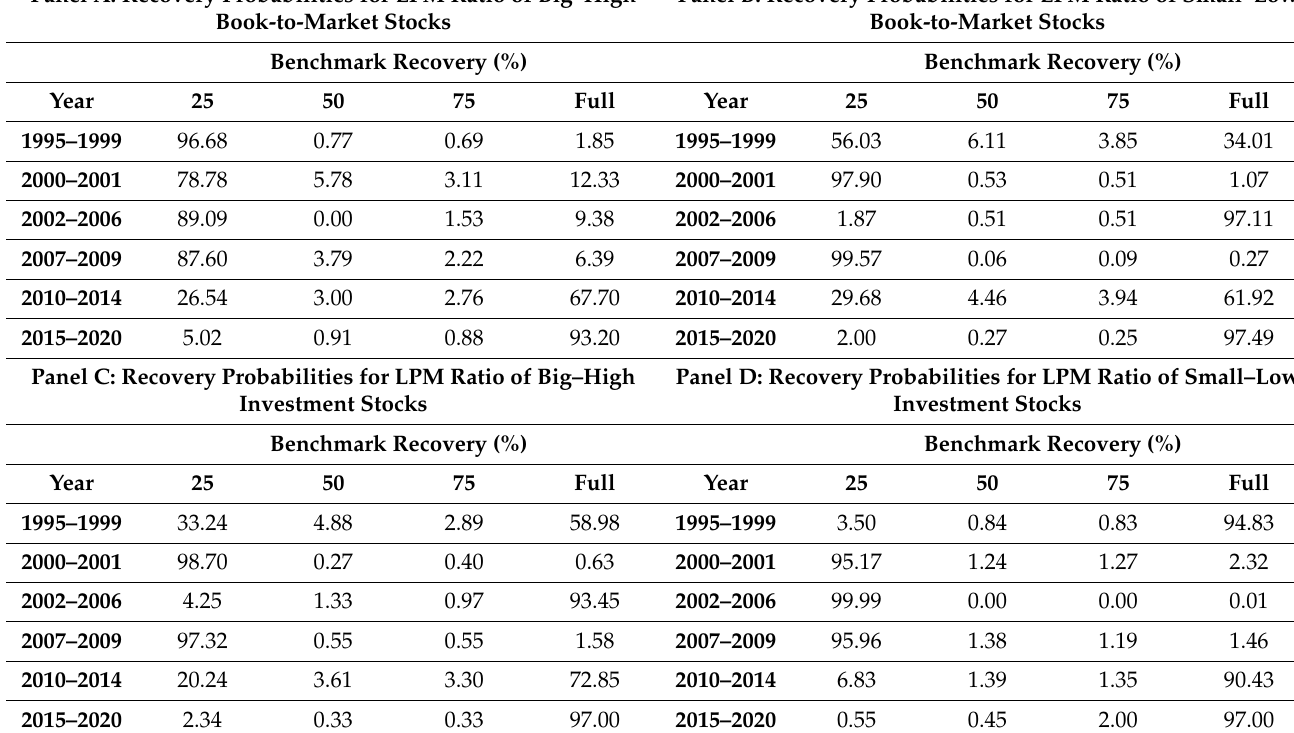
Table 2. Recovery Probabilities for LPM ratio of Six Types of Stocks for Different Time Periods. Panel A: Recovery Probabilities for LPM Ratio of Big–High Panel B: Recovery Probabilities for LPM Ratio of Small–Low Book-to-Market Stocks Book-to-Market Stocks Benchmark Recovery (%) Benchmark Recovery (%)